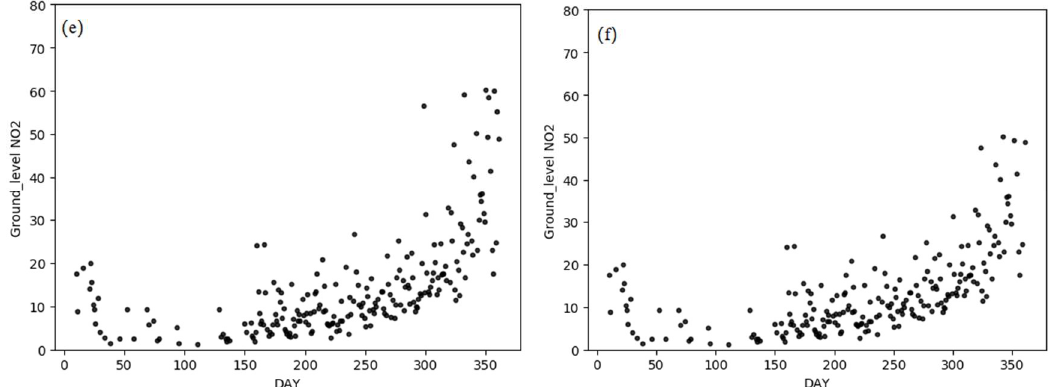
Figure 3. Comparison before (left-hand panels) and after (right-hand panels) quality control of ground sites. ( a ) before and ( b ) after quality control of the first site; ( c ) before and ( d ) after quality control of the second site; ( e ) before and ( f ) after quality control of the third site.